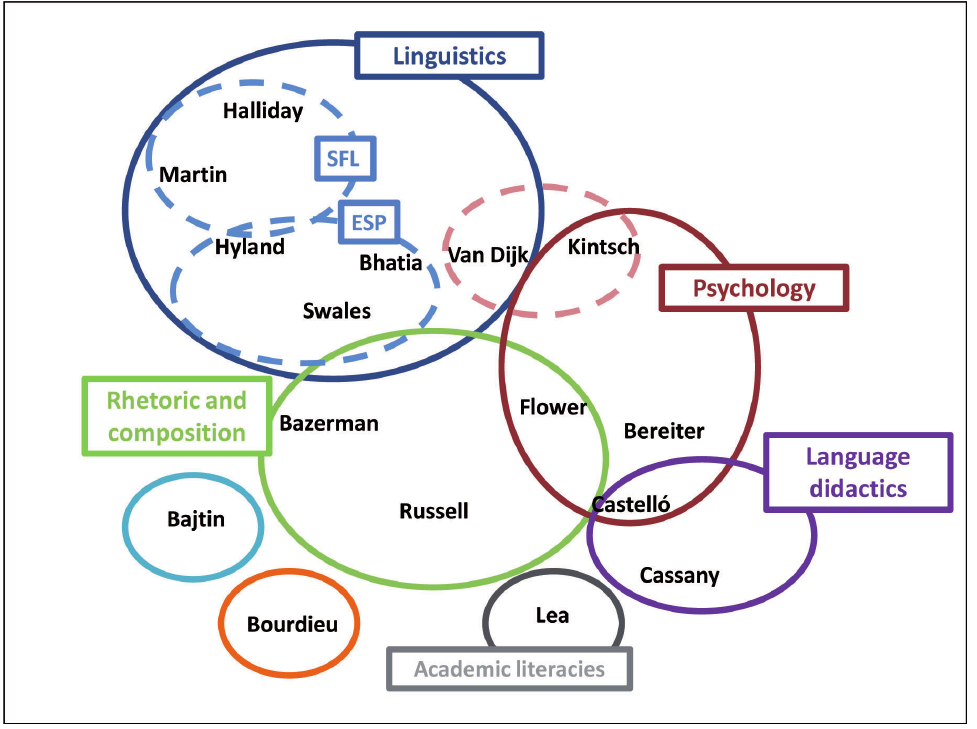
Figure 3: Disciplinary topography of cited text of top foreign influential authors in Latin American writing